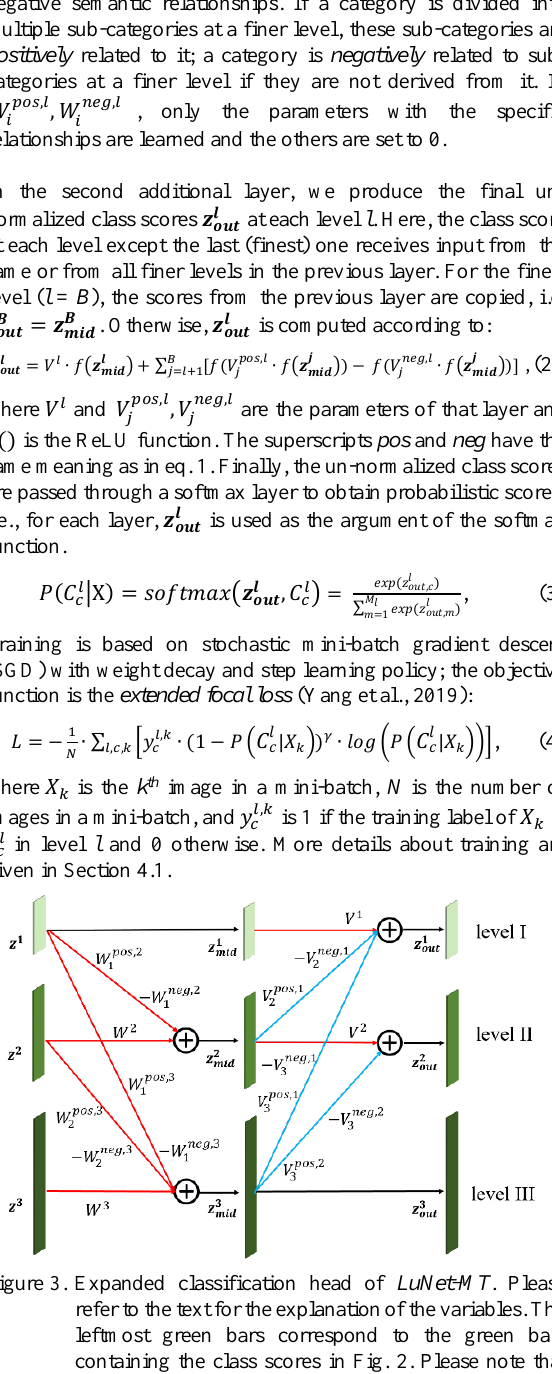
Figure 3. Expanded classification head of LuNet-MT . Please refer to the text for the explanation of the variables. The leftmost green bars correspond to the green bars containing the class scores in Fig. 2. Please note that ReLU activation is not shown here.